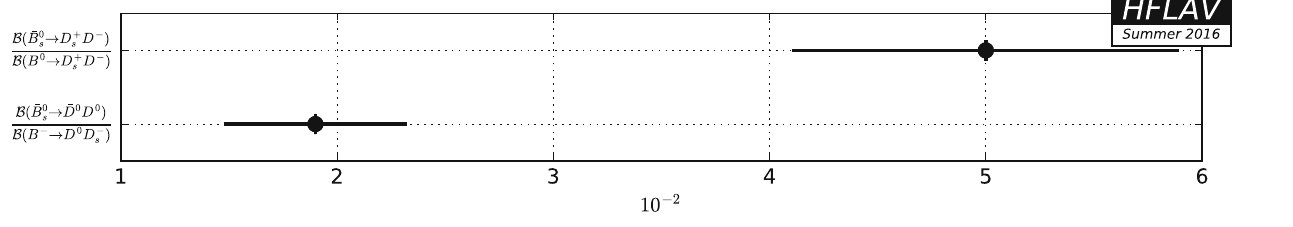
Fig. 160 Summary of the averages from Table